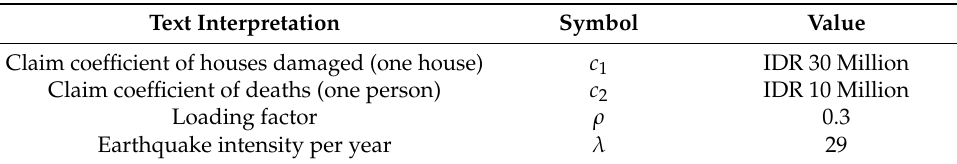
Table 5. Related parameter